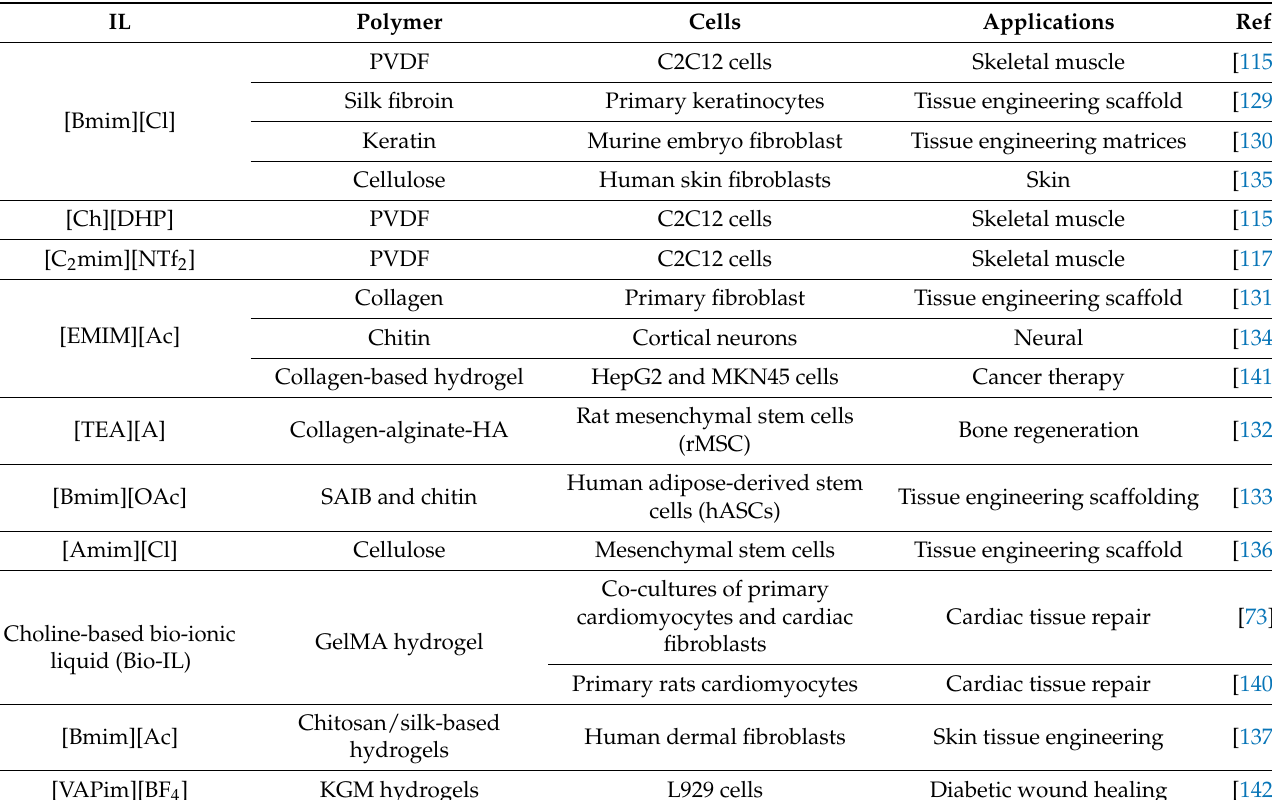
Table 2. IL/polymer composites for tissue engineering.